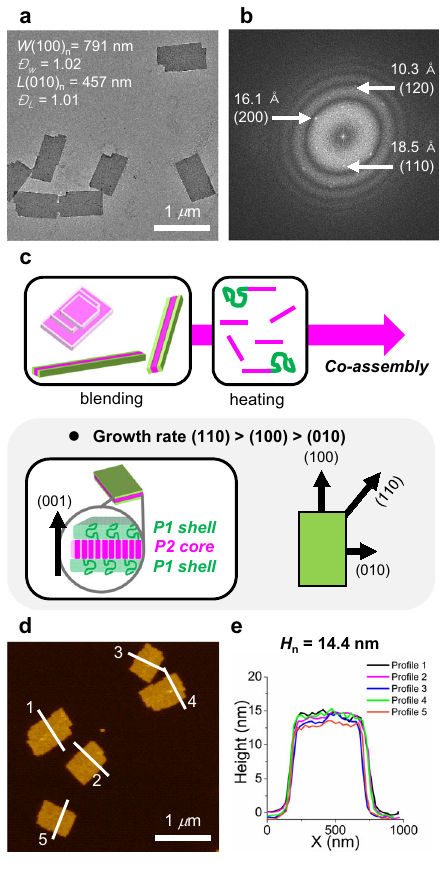
Fig. 2 Characterization of uniform monolayer 2D seeds. a TEM image of uniform 2D seeds generated by a heating and aging method using 2:1 blend ratio of P1 50 - b -P2 22 and P2 22 homopolymer. Numbers in the image indicate the average width ( W n ), length ( L n ), and dispersity ( Đ w or Đ L ). b FFT pattern from the HR-TEM image of the single 2D seed showing three main d -spacings of 10.3, 18.5, and 16.1 Å and their corresponding (hkl) planes. c Schematic representation of the formation of 2D seeds and their proposed detailed structures. Also included is their crystal array and observed crystal growth rates. d AFM image of 2D seeds and e height pro fi le along the white lines shown in the AFM image, indicating the average height ( H n